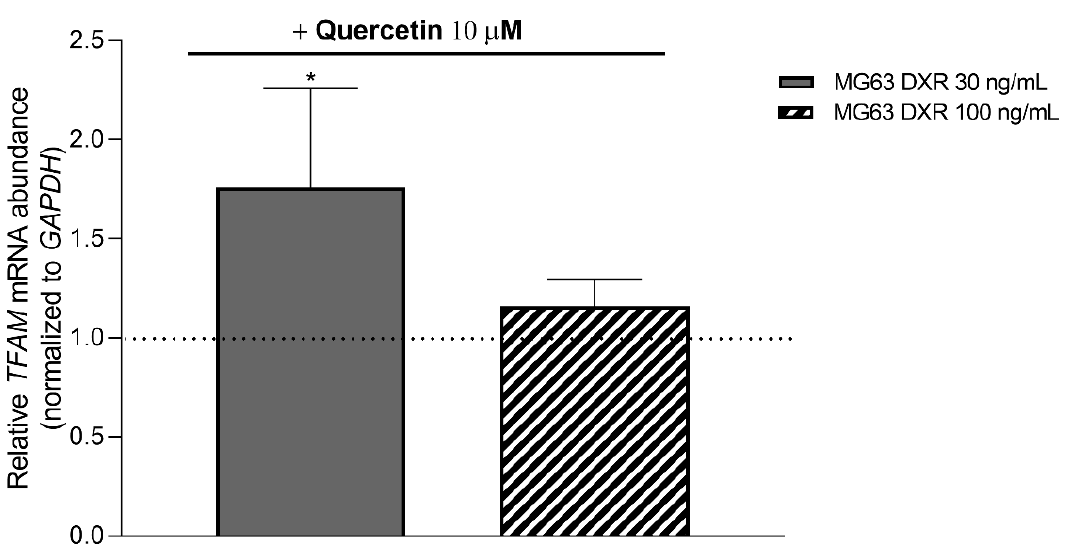
22 of 24 Figure A3. ( a ) Representative cytograms of apoptotic cells analyzed with Annexin V-PI staining. MG63, MG63 DXR 30 ng/mL and MG63 DXR 100 ng/mL cells were treated 72 h with quercetin 10  M. The graphs represent the quantification of early ( b ) and late apoptosis ( c ) by showing the ratio between treated and untreated. ( d ) Representative cytograms of apoptotic cells analyzed with An-